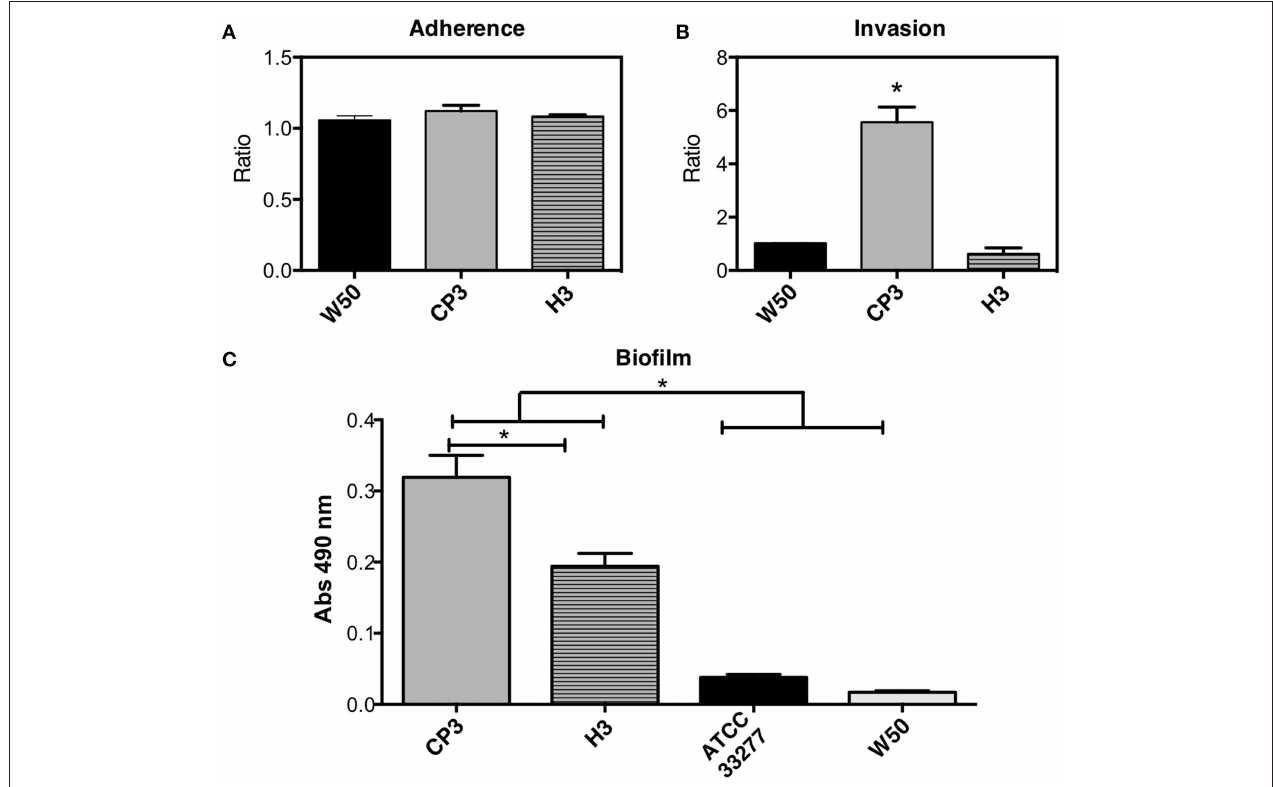
FIGURE 5 | Cellular adherence (A) , invasion (B) , and biofilm formation (C) of different strains of Porphyromonas gingivalis exhibiting different fimA genotypes. Adherence (A) or invasion (B) were calculated as: the number of viable CFU in infected cells/the number of CFU of initial bacteria inoculum. Biofilm formation (C) was determined by safranin staining. The dye retained in the biofilm was eluted and measured at 490nm. Invasion, adherence and biofilm assays were performed in triplicate on at least three independent occasions. Values that differ significantly from controls are indicated (SEM; n = 3; * p ≤